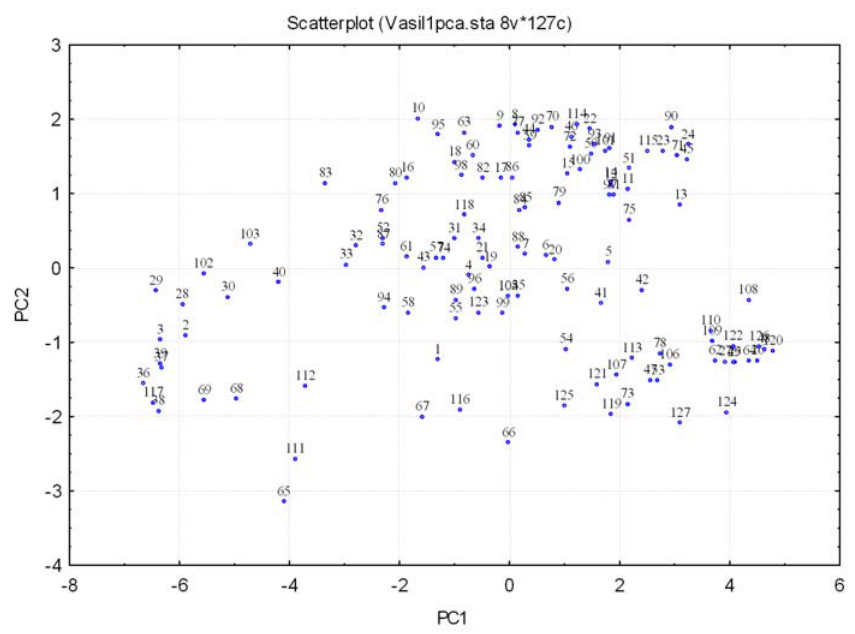
Fig. 5 Scatter plot of scores corresponding to the first two principal components (Fuzzy PCA, first direction).